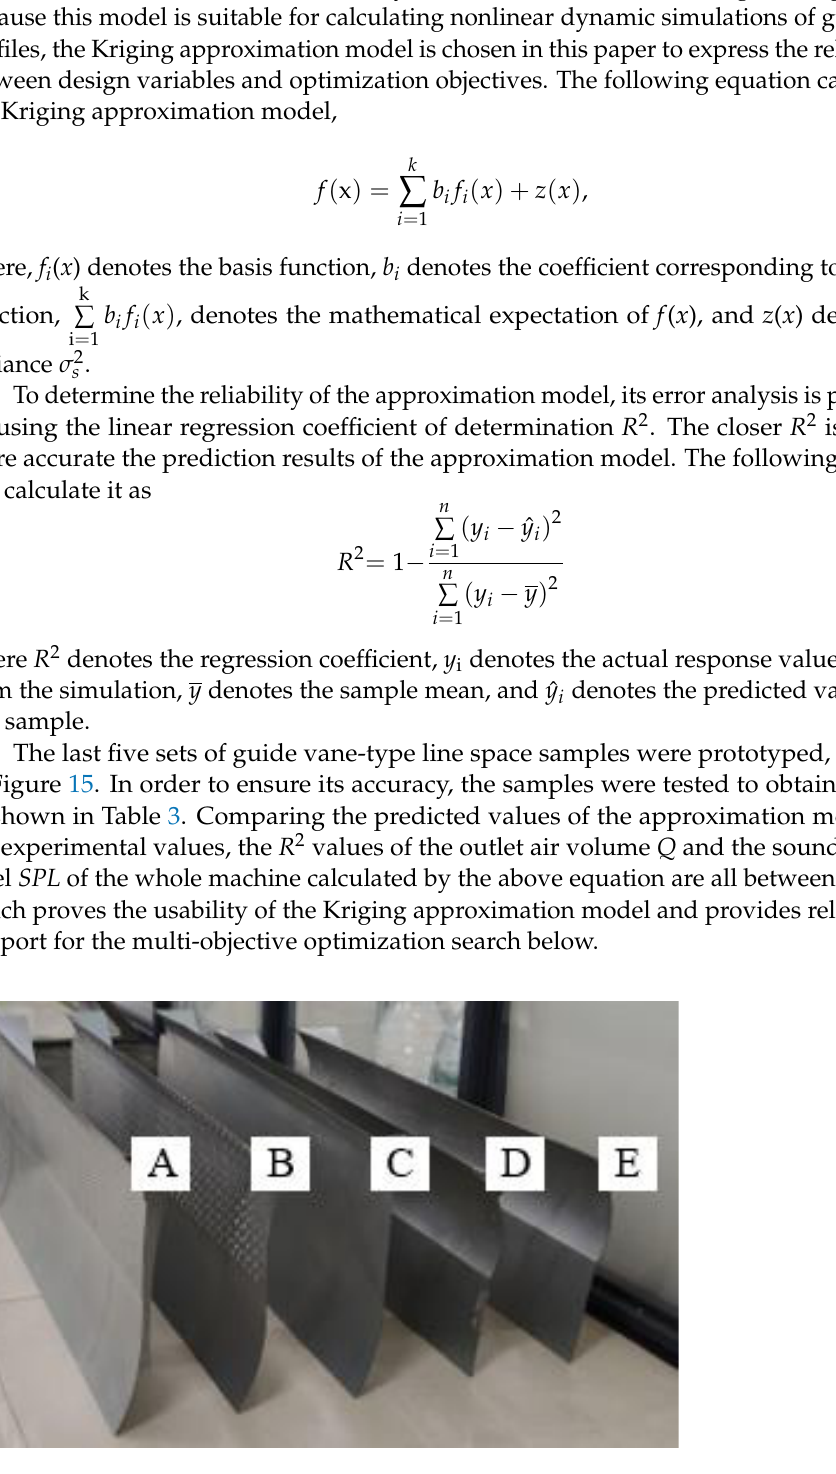
Figure 15. Verification of guide plate samples.